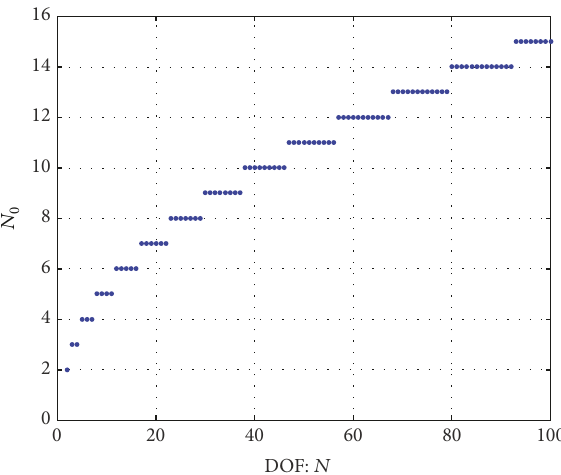
Figure 1: Relationship between 𝑁 and 𝑁 0